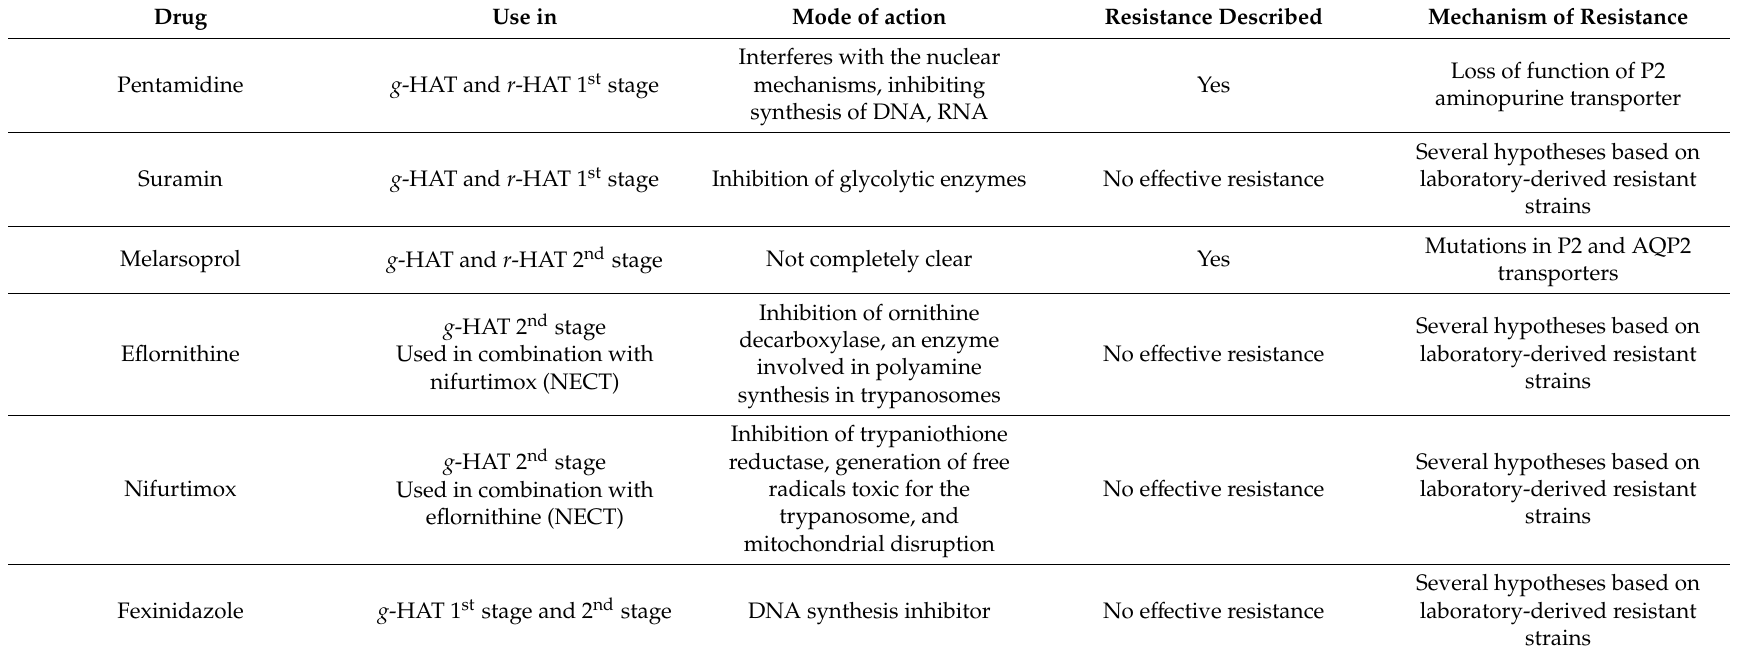
Table 3. Drugs for HAT treatment, their uses, and mechanisms of